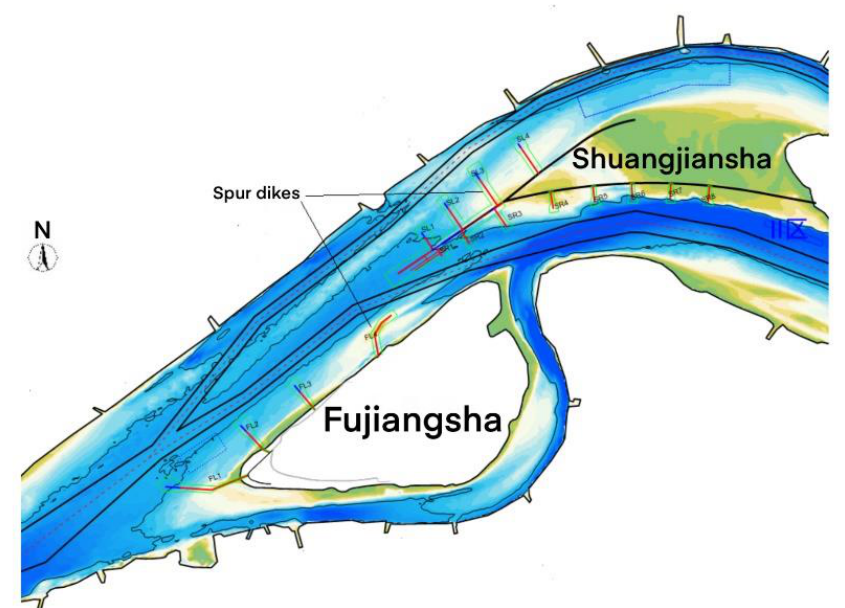
Figure 10. Layout of regulating structure in Fujiangsha Waterway.